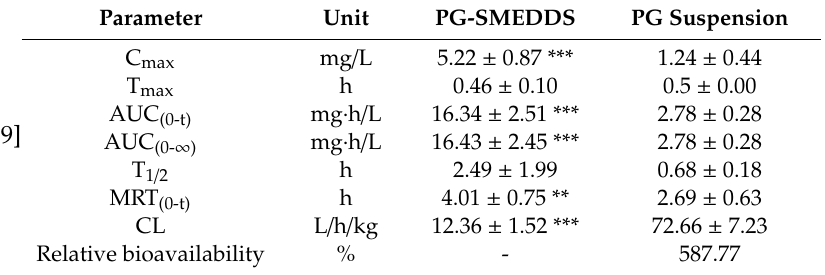
Figure 7. Plasma concentration-time profiles of PG in rats after oral administration of PG-SMEDDS and PG suspension (mean ± SD, n = 6). Table 5. Pharmacokinetic parameters of PG-SMEDDS and PG suspension in rats (mean ± SD, n = 6). C max : the maximum plasma concentration; T max : the time to reach maximum plasma concentration; AUC: area under the curve; MRT: mean residence time; T 1 / 2 : half-life; CL: